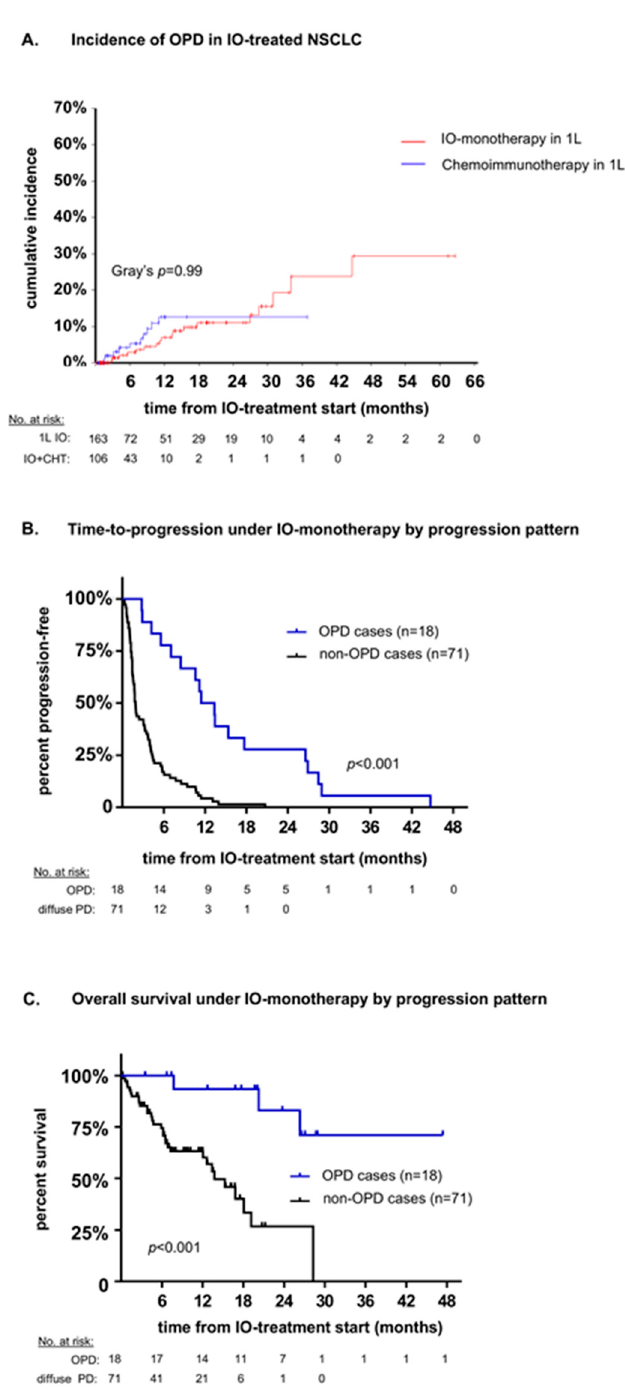
Figure 4. Incidence and prognosis of oligoprogression during first-line immunotherapy (to the right). ( A ) Cumulative incidence of oligoprogression (OPD) in stage IV NSCLC under first-line IO monotherapy ( n = 163) vs. first-line chemoimmunotherapy ( n = 106) in the entire study population (Figure 1). Patients without disease progression were censored, while OPD and di ff use progression were considered as competing risks. Cumulative incidence at 2 years was 12.6% for chemoimmunotherapy-treated vs. 11.0% for IO-monotherapy-treated patients (Gray’s p = 0.99). ( B ) Time-to-progression for NSCLC (Table 1, log-rank p < 0.001). ( C ) Overall survival (OS) of NSCLC patients developing OPD ( n = 18) vs. di ff use disease progression ( n = 71), under first-line IO monotherapy (Table 1, log-rank p <